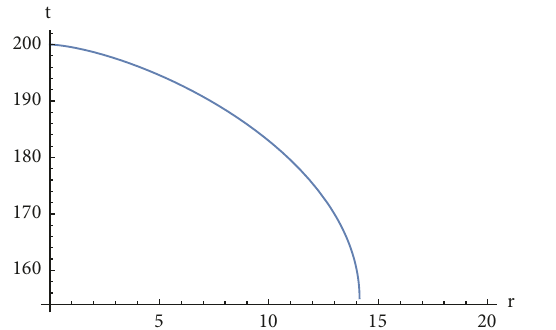
Figure 4: The trajectory of an infalling particle in terms of the proper time 𝜏 . The particle falls continuously to the singularity 𝑟 = 0 in a finite proper time. The figure is plotted for 𝜆 = 0.1 and 𝑀 = 1